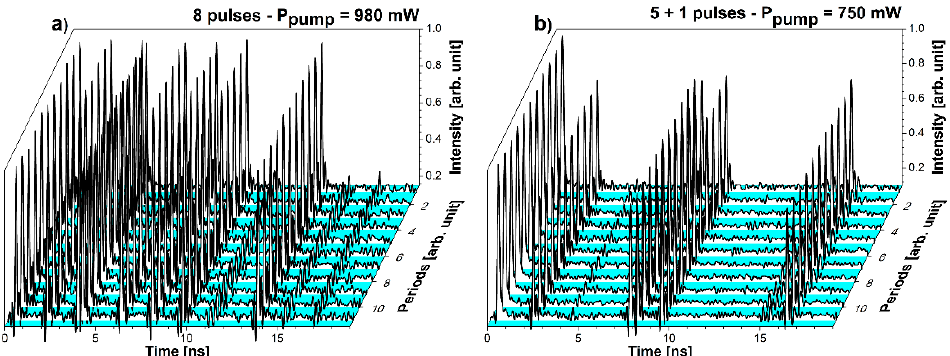
Figure 5. Successive temporal traces show a lack of drift among pulses in states: ( a ) 8 pulses; ( b ) 5 + 1 pulses.